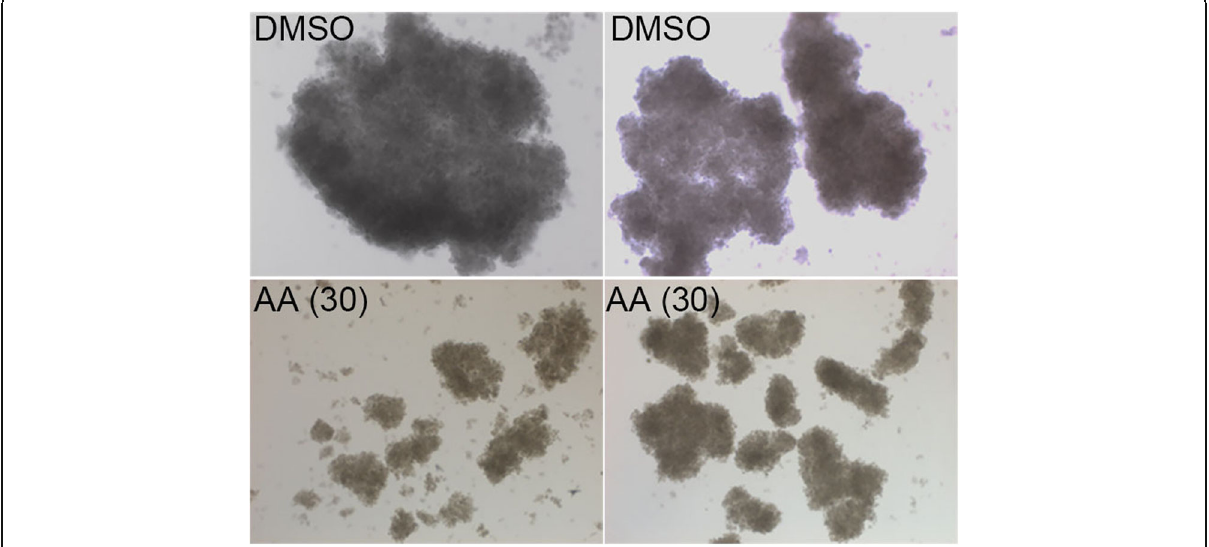
Fig. 3 AA induced a decrease in the number and size of spheroids in PANC-1 cells. The same number of cells were seeded onto Nunclon ™ Sphera plates. Next day, media was replaced with fresh media containing either 3 μ l of DMSO or 3 μ l of AA stock solution in 10 ml media to make the final concentration of AA at 30 nM. Every other day, half of the media was replaced with fresh media containing respective reagent. 7 days after the initial treatment, photos were taken from two independent assays